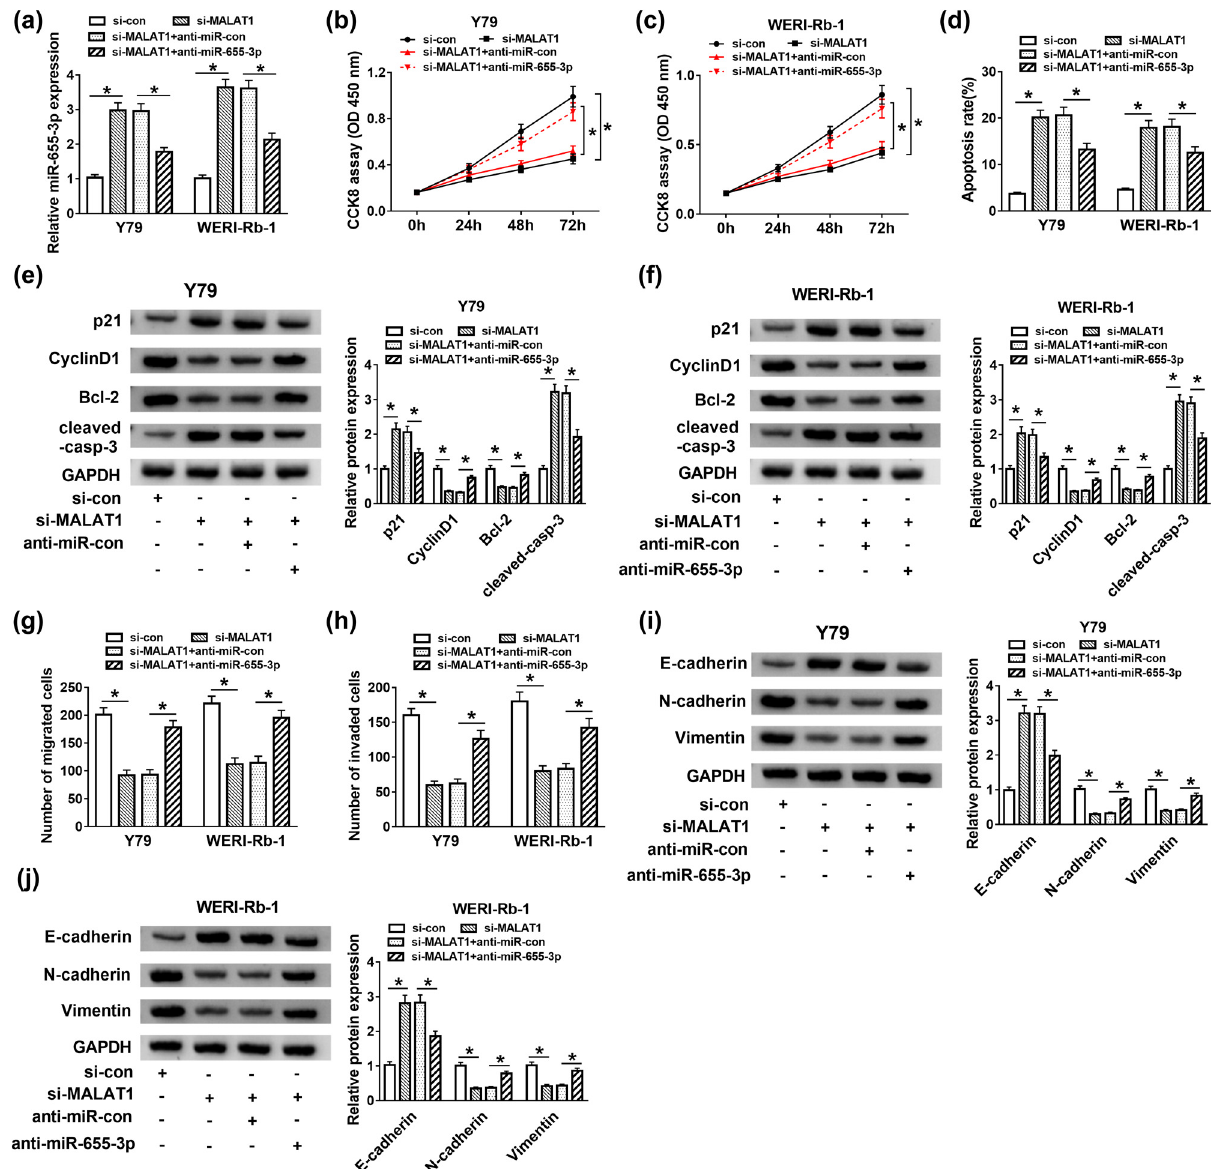
Figure 4: MALAT1 regulated RB progression by sponging miR - 655 - 3p. ( a – j ) The Y79 and WERI - Rb - 1 cells were transfected with si - con, si - MALAT1, si - MALAT1 + anti - miR - con, or si - MALAT1 + anti - miR - 655 - 3p. ( a ) The level of miR - 655 - 3p was measured by RT - qPCR after transfection for 24 h. ( b and c ) The cell viability was examined by CCK8 assay after transfection for 0, 24, 48, and 72 h. ( d ) The apoptosis rate was evaluated through fl ow cytometry after transfection for 48 h. ( e and f ) The protein levels of p21, Cyclin D1, Bcl - 2, and cleaved - casp - 3 were tested via western blot assay after transfection for 48 h. ( g and h ) The migration and invasion abilities were estimated by transwell assay after transfection for 24 h. ( i and j ) After transfection for 48 h, the protein levels of E - cadherin, N - cadherin, and Vimentin were detected by western blot. * P <